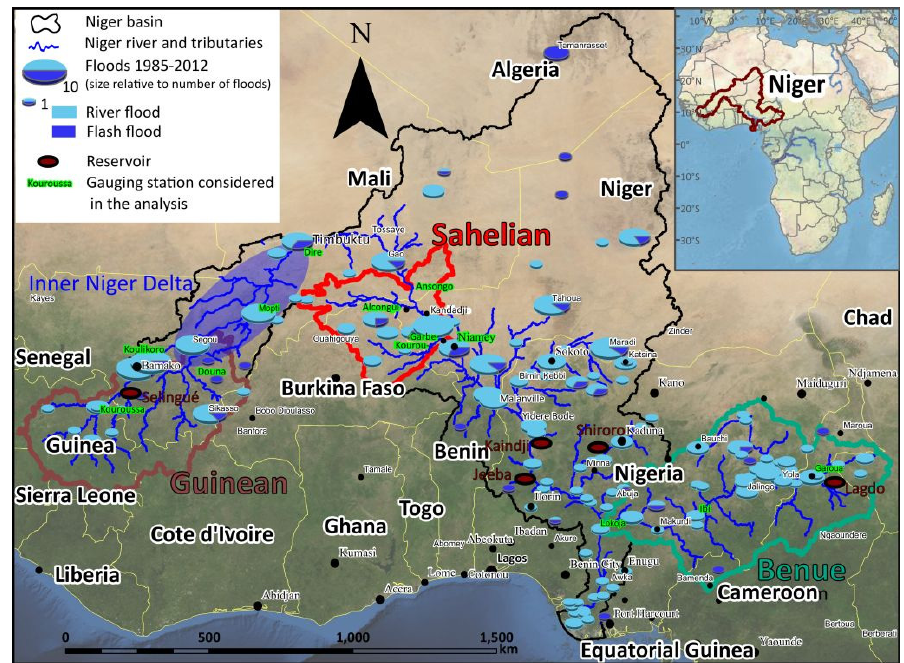
Figure 1. Niger River Basin: Source areas of floods in the Guinean, Sahelian and Benue regions, with location and number of catastrophic floods plotted for river and areal floods [29–31]. Discharge gauging stations used for analysis are marked in green and reservoirs as red ovals [32].